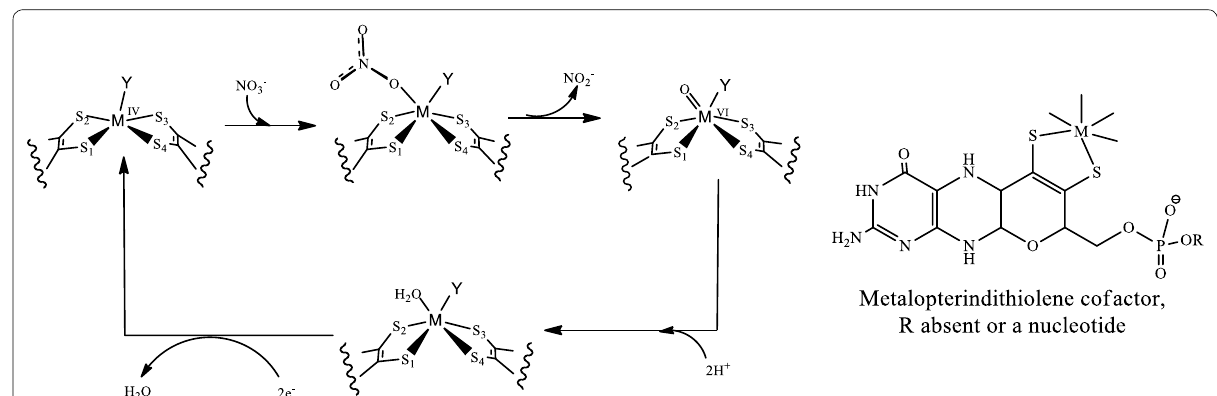
Fig. 2 Schematic description of the proposed mechansim [1] for the nitrate reduction, where M cleotide cofactor is